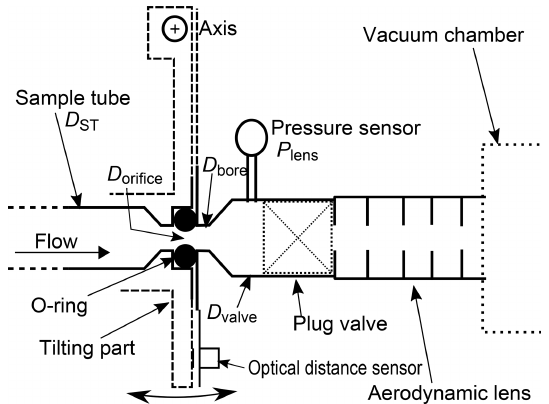
Figure 3. Principal drawing of the CPI design. The tilting part can be moved by a motor pulling it over a spindle mechanism. The con- troller uses the output of a pressure sensor downstream of the O-ring ( P lens ), as indicated in the drawing. An additional optical distance sensor between the tilting part and the valve block is used to en- sure safe stop limits for the movement. Relevant inner diameters for sample flow are denoted with D ST (2mm), D bore (1mm), D orifice (variable), and D valve